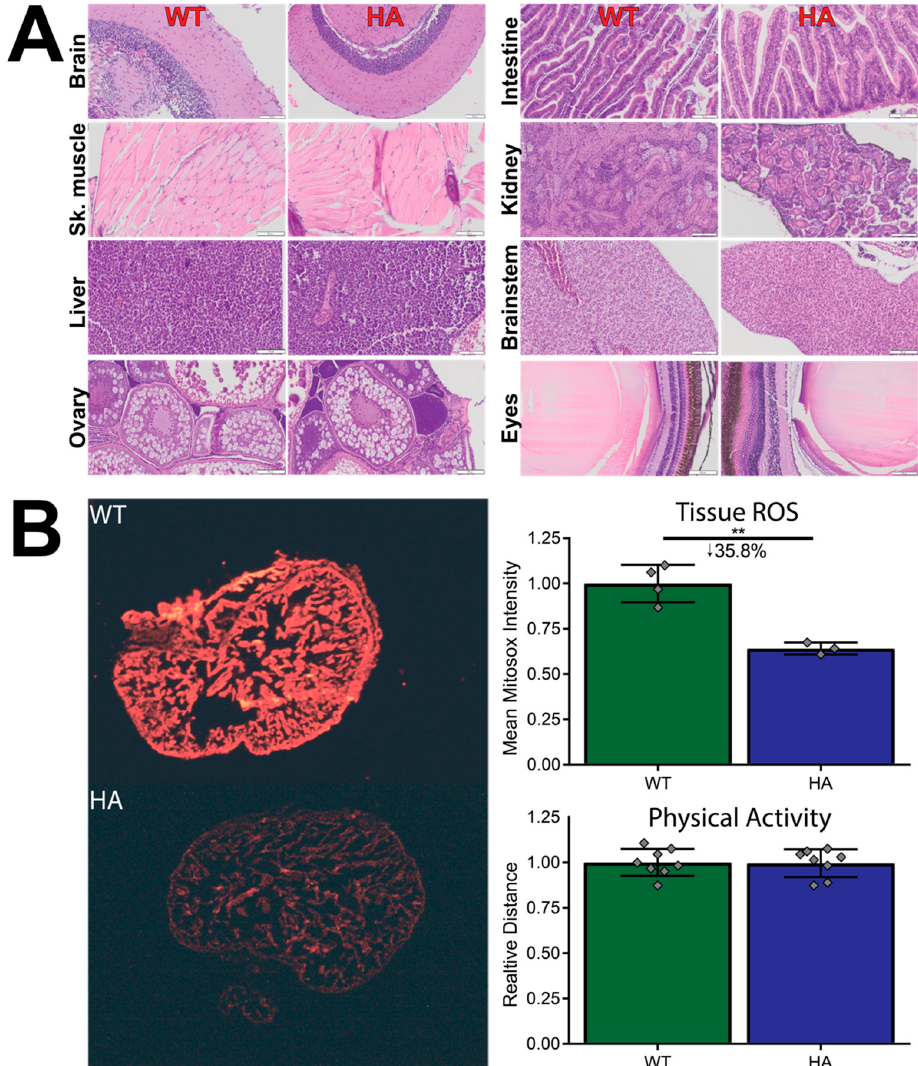
Figure 5. Tissue comparisons between WT and p66Shc hypomorphic allele zebrafish. ( A ) Representative H&E stains of WT and hypomorphic allele zebrafish organs. Organs do not show tissue-level abnormalities. ( B ) Physical activity is not affected in the p66Shc − /+ (HA) zebrafish line, but tissue ROS levels are significantly reduced. N = 8 for physical activity, 3–4 for tissue ROS. ** = p < 0.01, mean ± SD. Both images were uniformly contrast- and brightness-enhanced for clear visualization.